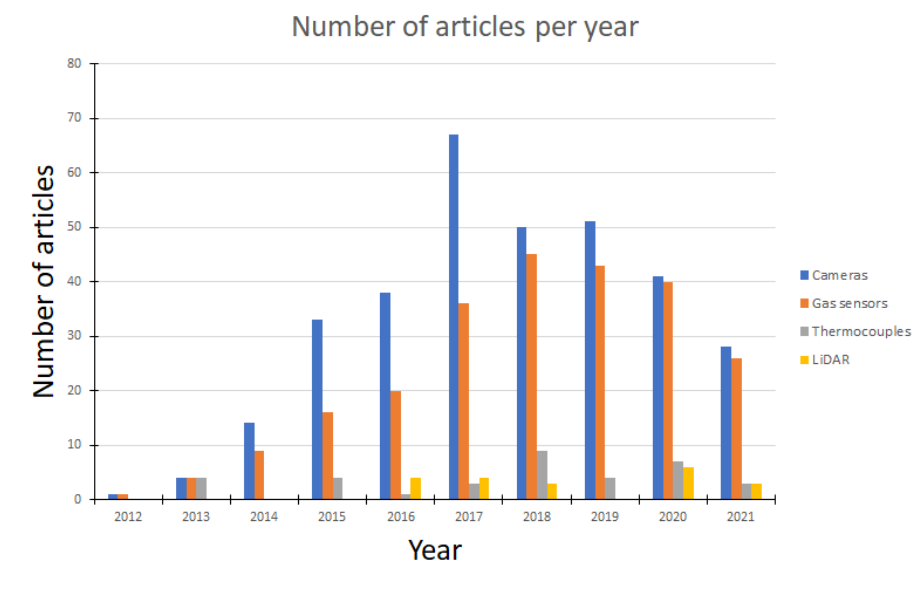
Figure 15. Histogram of articles about cameras, gas sensors, thermocouples, and